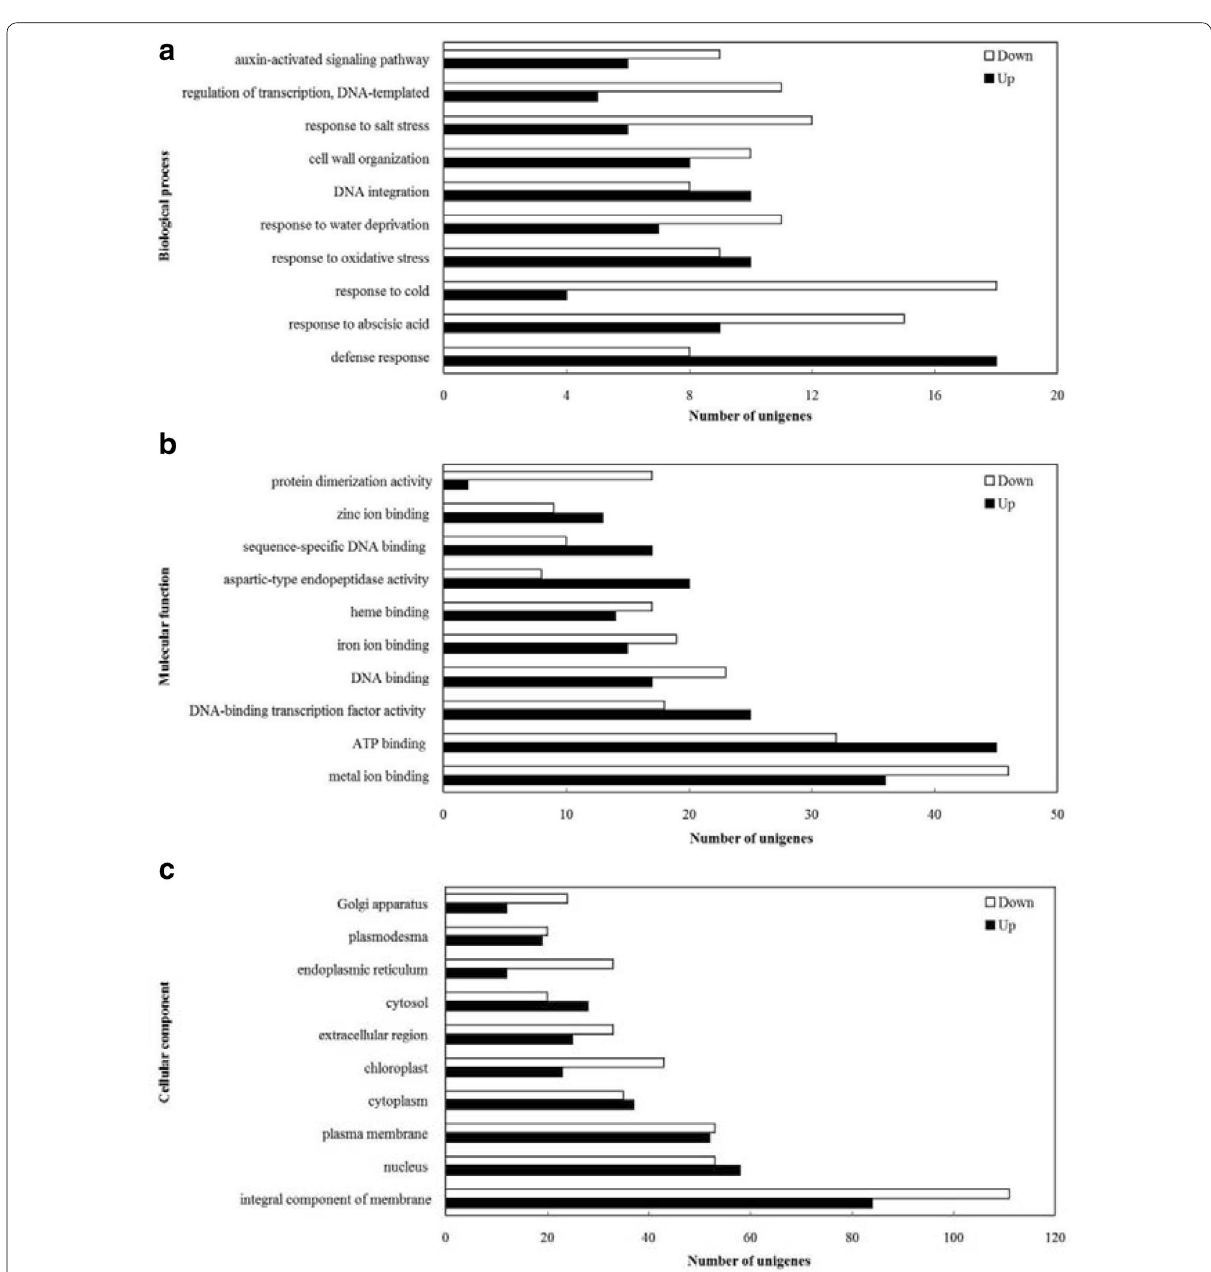
Fig. 5 GO function categories of the DEGs in anthurium under Put treatment at 1.0 mM. Unigenes were assigned to three categories: a biological processes, b molecular functions, and c cellular